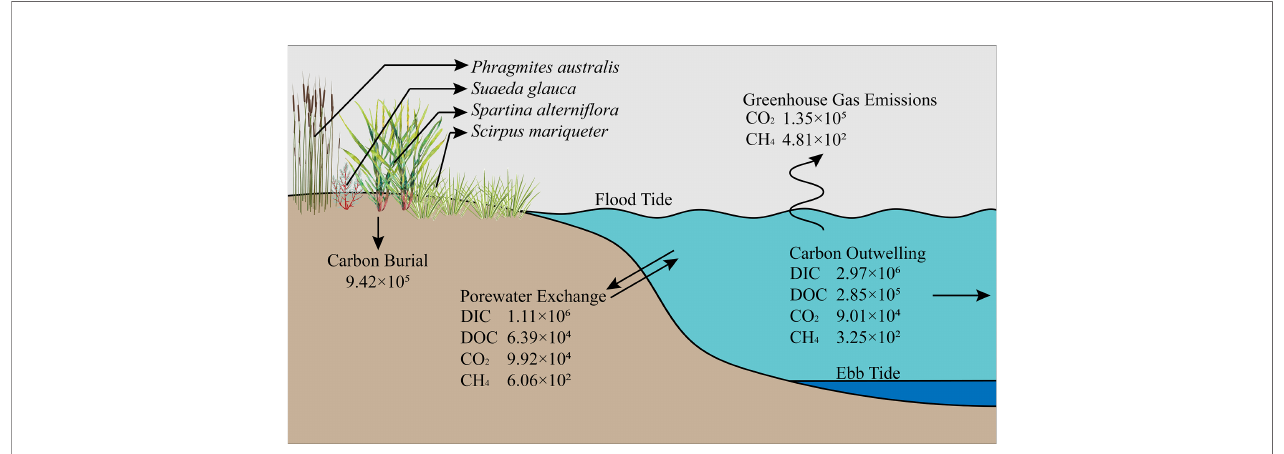
FIGURE 8 | Conceptual model of major carbon fl ows (including carbon burial, porewater exchange, carbon outwelling and GHG emissions, mol d -1 ) in Andong